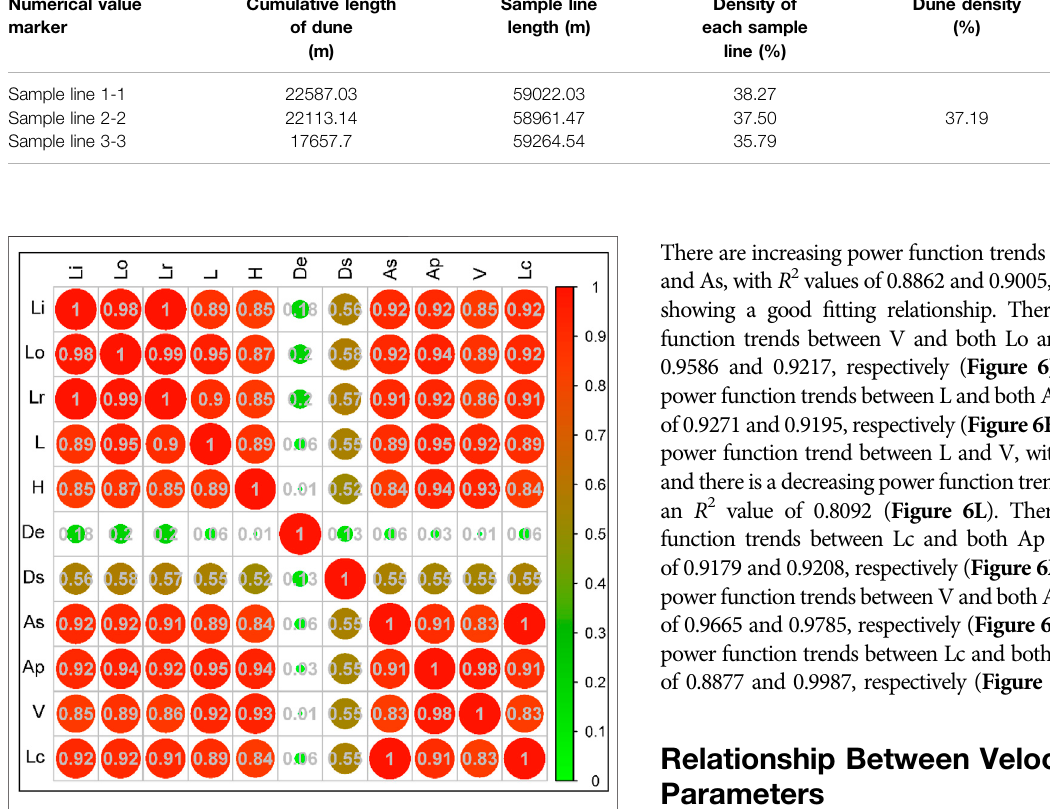
The results of the function fi tting relationship of the morphological parameters of the sand dunes are shown in Figure 6 . The extracted morphological parameters of the measured dunes were plotted, and it was found that Lo and Lr both exhibit smaller power function trends with increasing Li, with R 2 values of 0.9545 and 0.9965, respectively ( Figure 6A ). The small decreasing trend, with R 2 values of 0.7425 and 0.6772,